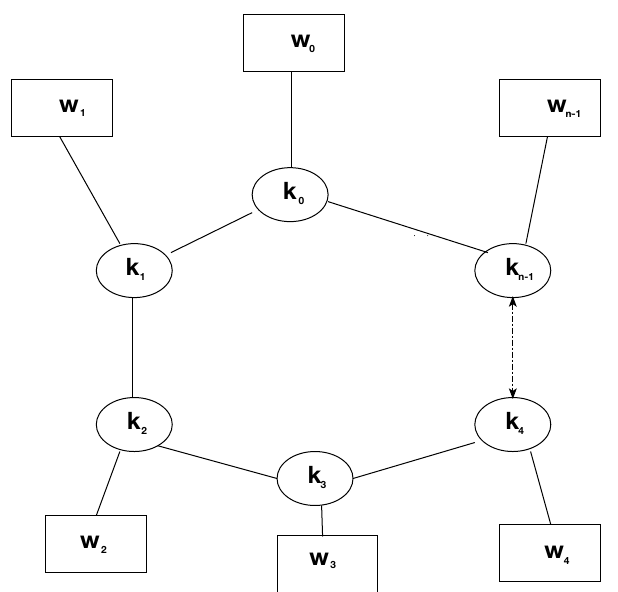
Figure 1 . The Kronheimer-Nakajima quiver for a regular U( N ) instantons on C 2 = Z n . Each node denotes the unitary group with the labelled rank. The circular nodes denote gauge groups and the square nodes denote the (cid:13)avour symmetries.